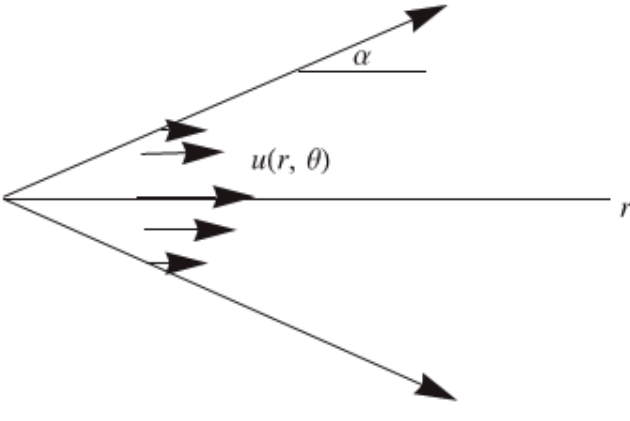
Figure 1. Schematic diagram of the flow